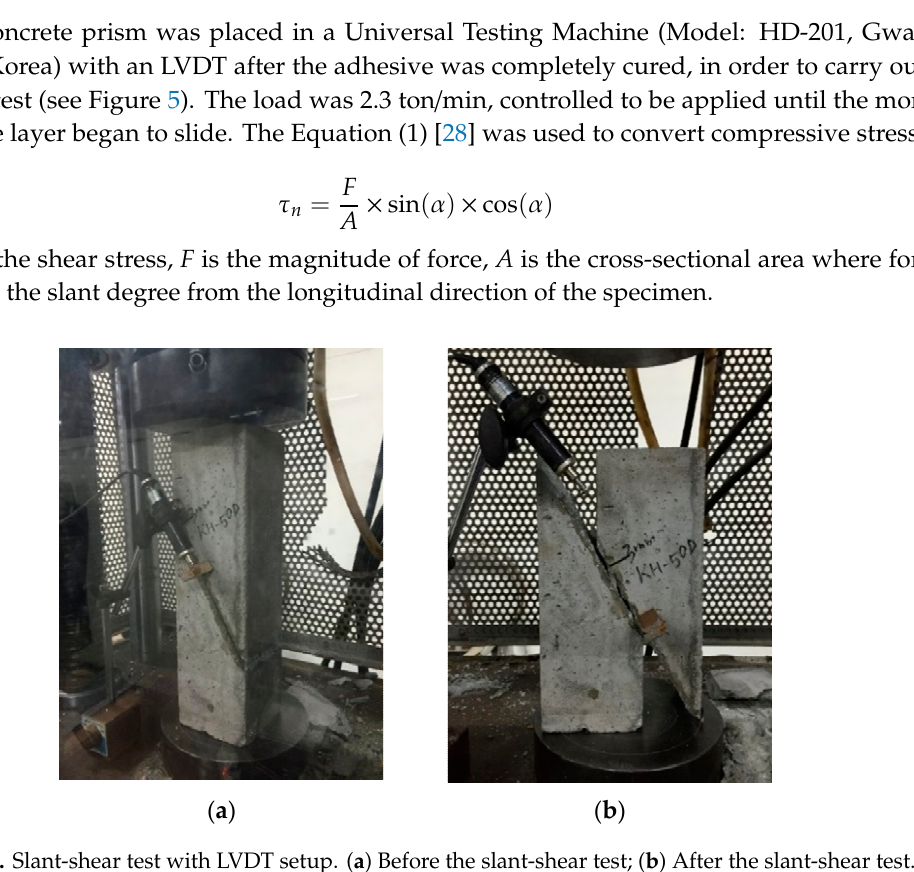
Figure 5. Slant-shear test with LVDT setup. ( a ) Before the slant-shear test; ( b ) After the slant-shear test.